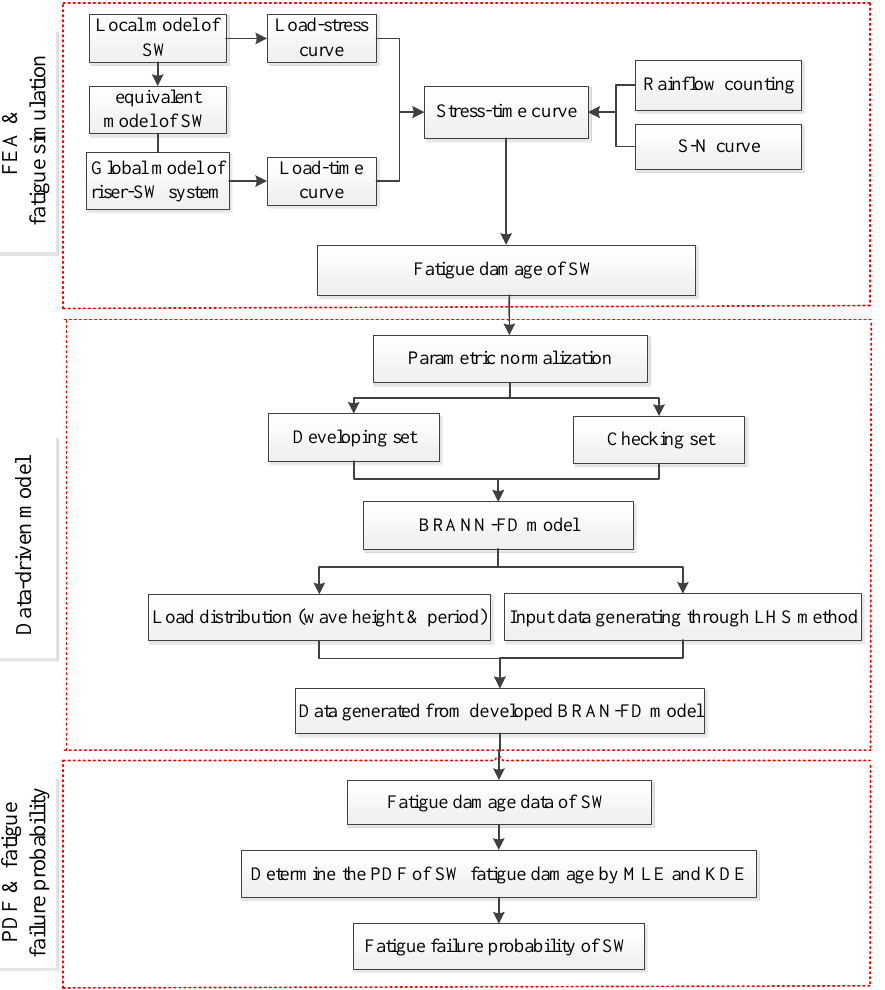
Figure 4. Framework for predicting the fatigue failure probability of